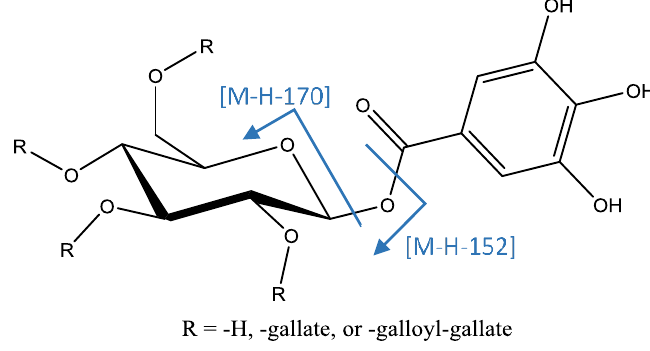
Figure 8. Structure and fragments of gallotannins.